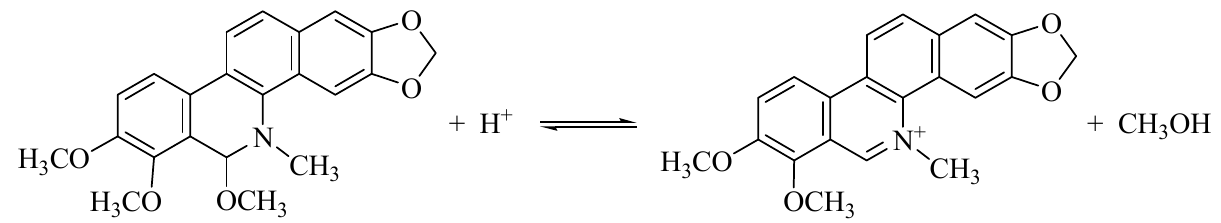
Figure 3. Absorption spectra of CH ( a ) and ECH ( b ) in methanol–water solutions containing different proportions of water. C CH = 6.50 μ g·mL − 1 , c ECH = 7.95 μ g·mL − 1 .